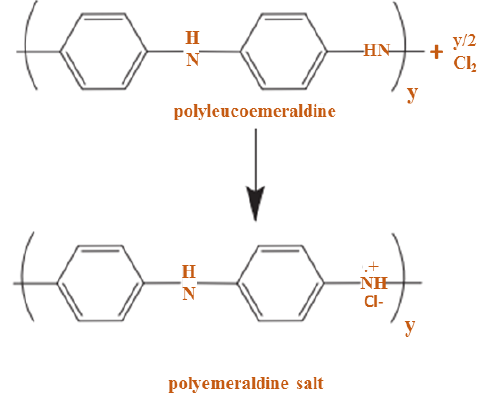
Figure 11. Structure of doping in PANI.